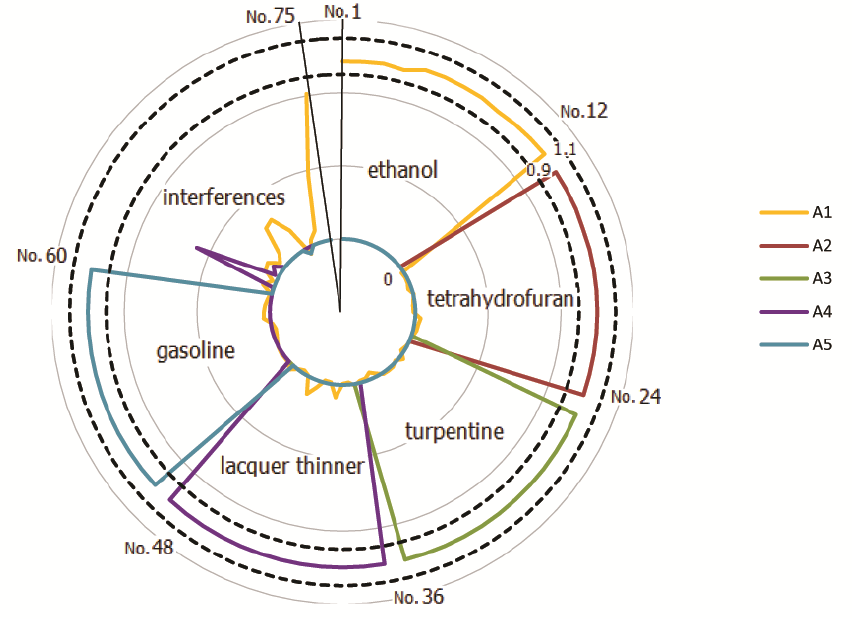
Figure 7. Back propagation artificial neural network (BP-ANN) output layer ([A1 A2 A3 A4 A5] T ) of 75 test samples. The area between the two dashed lines in the figure is the positive element interval.